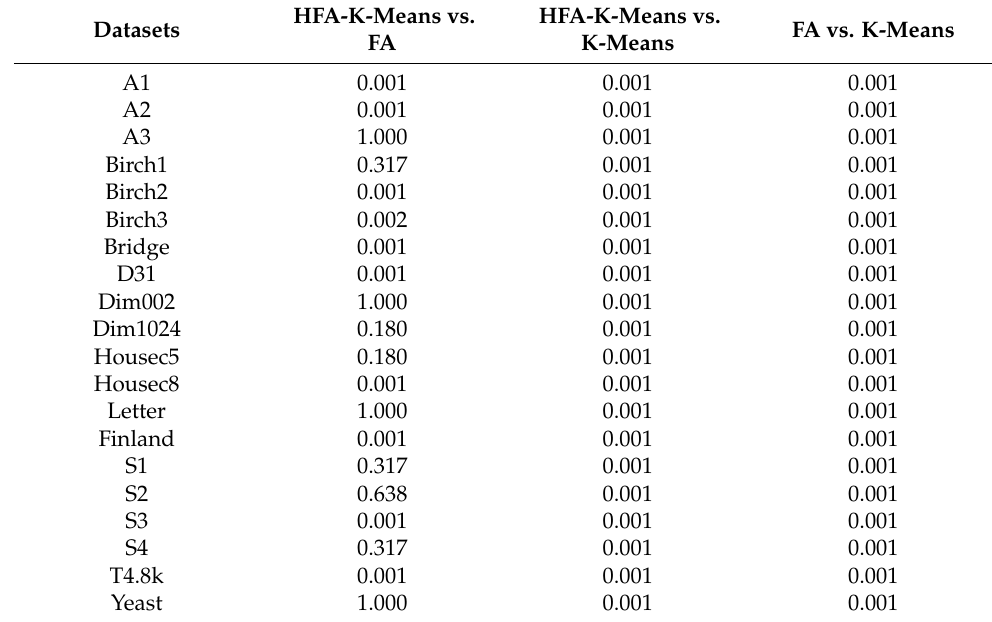
Table 11. Wilcoxon signed-rank test p values for equal medians on DB Index. HFA-K-Means Datasets